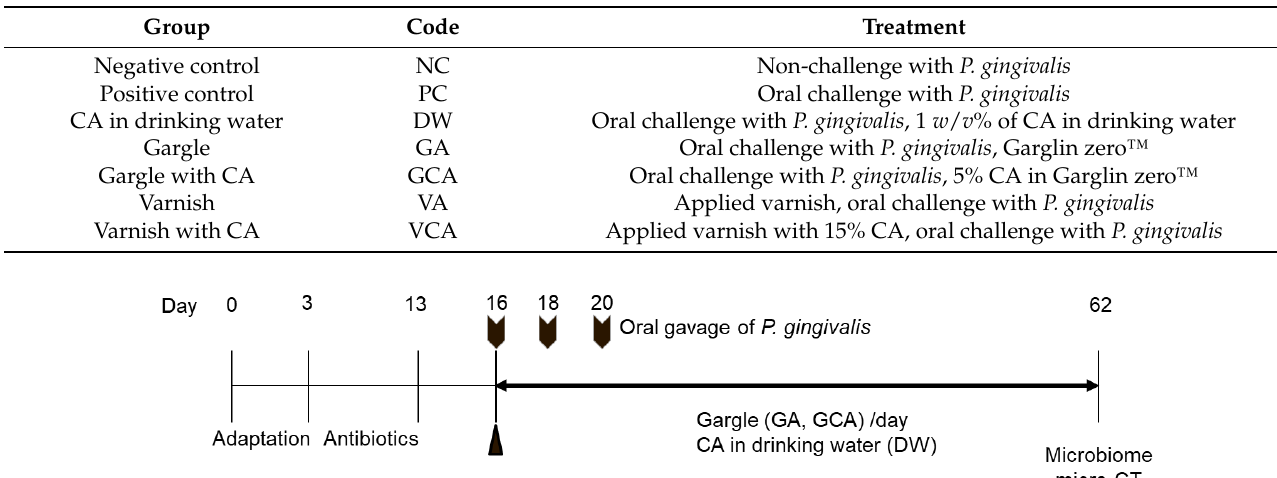
Table 1. Experimental groups in the animal study.